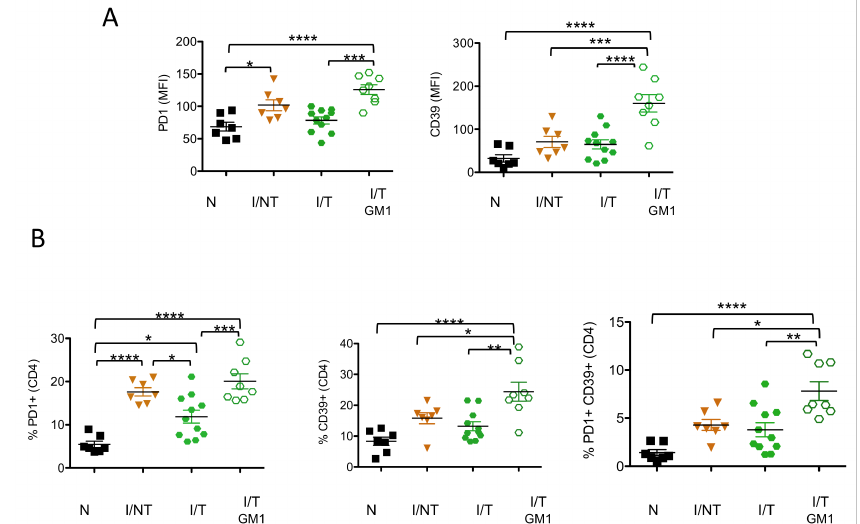
Figure 5. Effects of NK cell depletion on the expression of inhibitory receptors on CD4 + T cells. NK cells in infected/treated mice were depleted, or not, as indicated in Figure 2A. Spleen cells were isolated at day 14 p.i. and flow cytometry-analyzed to assess the expression levels of PD-1 and CD39 molecules on CD4 + T cells ( A ) and the frequency of PD-1- and CD39-expressing cells ( B ) ; the data correspond to 3 independent experiments with the following number of mice per group: naïve (N) ( n = 7); infected/non-treated (I/NT) ( n = 6); infected/treated (I/T) ( n = 11), infected/treated-GM1 (I/T GM1) ( n = 8) (* p < 0.05; ** p < 0.01; *** p < 0.001, **** p <